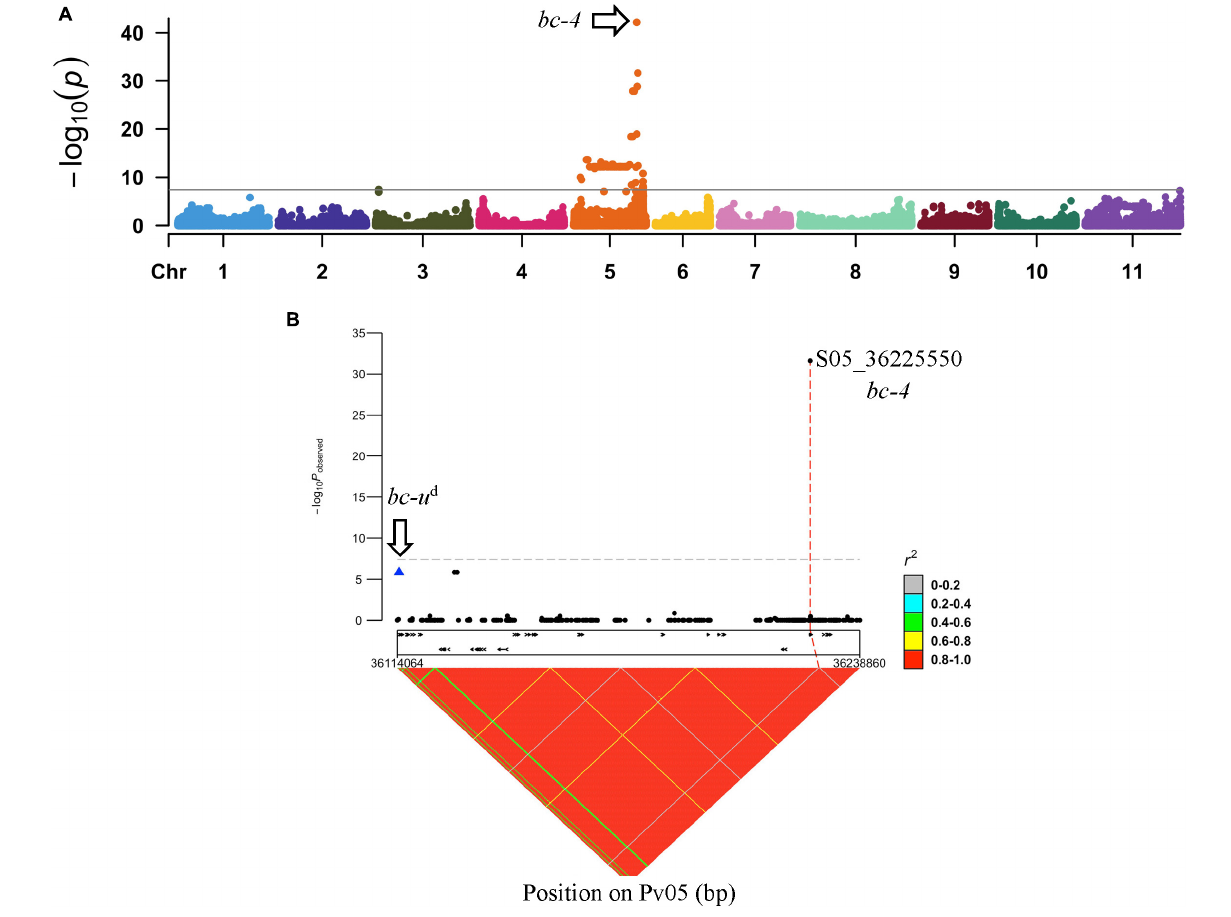
10,084-bp deletion that truncates three exons from the 3 (cid:48)